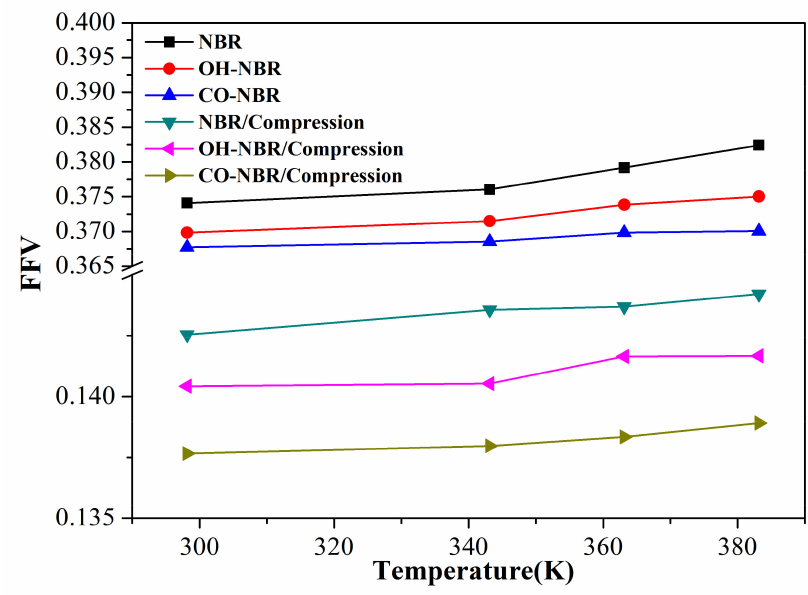
Figure 3. The FFV of the unaged and aged NBR models under the different conditions.